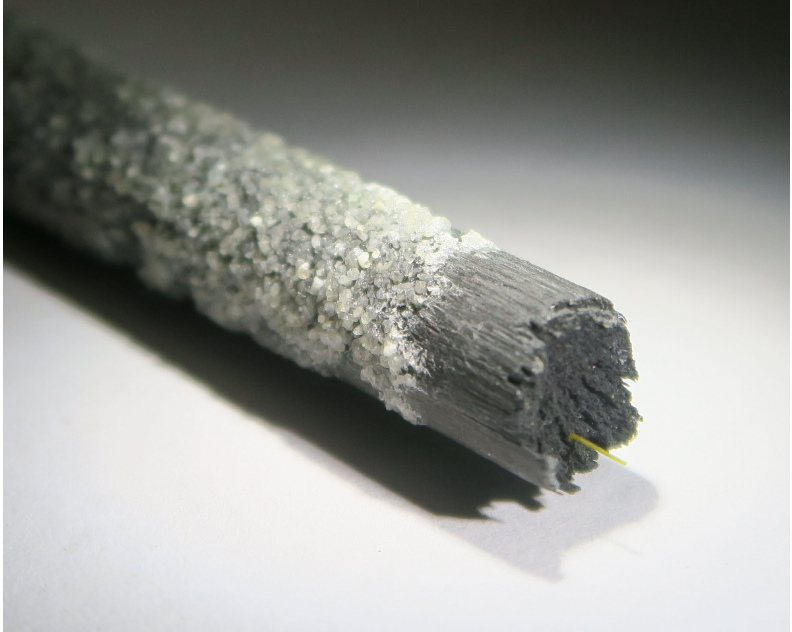
Figure 16. Quartz-sand-coated CFRP tendon showing the failure pattern with the integrated opti- cal